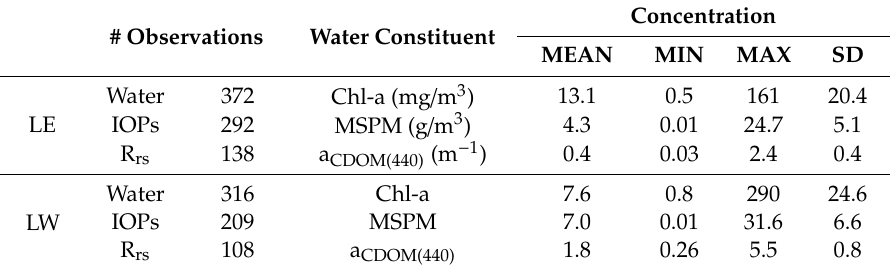
Table 1. A summary of in situ optical and water quality parameters from lakes Erie (LE) and Winnipeg (LW). # Observations Water